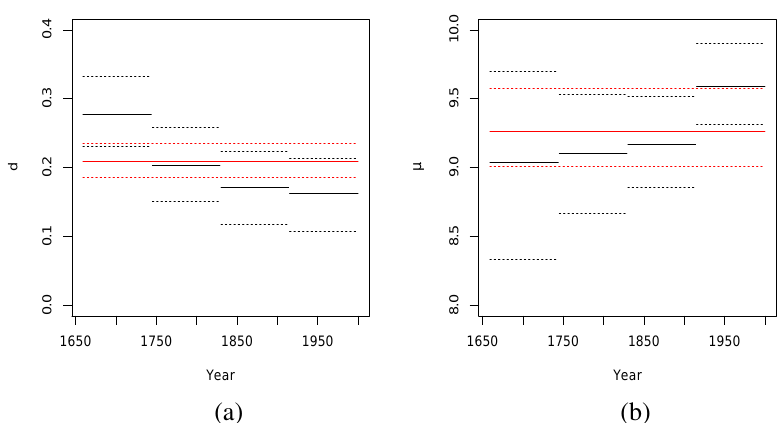
Figure 16. CET time series; posterior estimate (solid line) and 95% credibility interval (dotted line) for four blocks (black) and whole index (red) for (a) d , (b) µ .